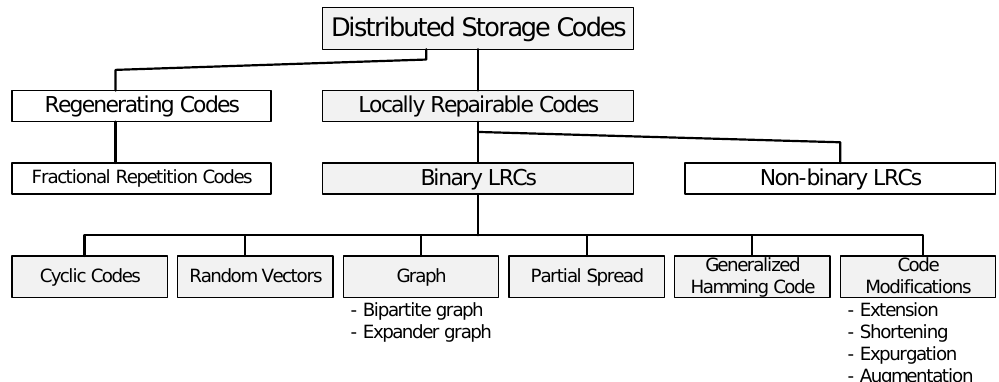
Figure 1. Classification of binary locally repairable